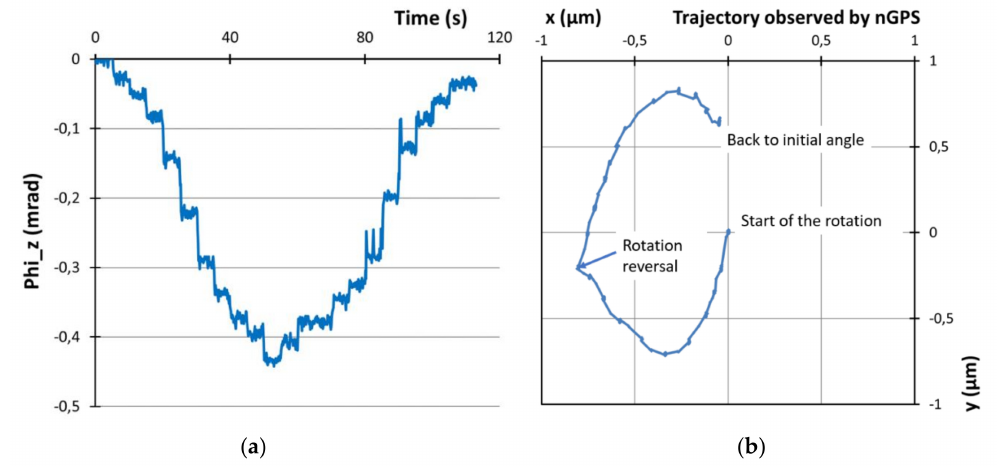
Figure 6. Investigation of motion of fluid bearing using nanoGPS encoder: ( a ) measured angle; ( b ) displacement in the (x, y)